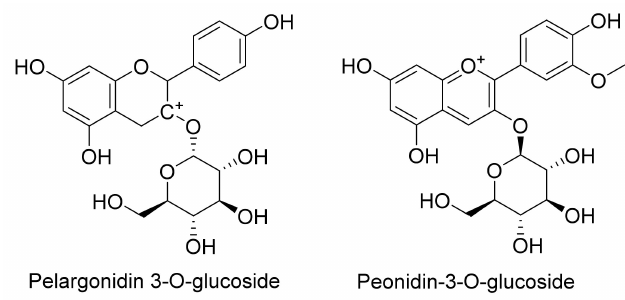
Figure 8. The main compounds found in purple corn.